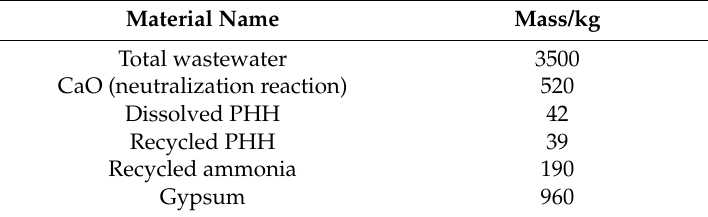
Table 4. Results of the treatment of PHH production